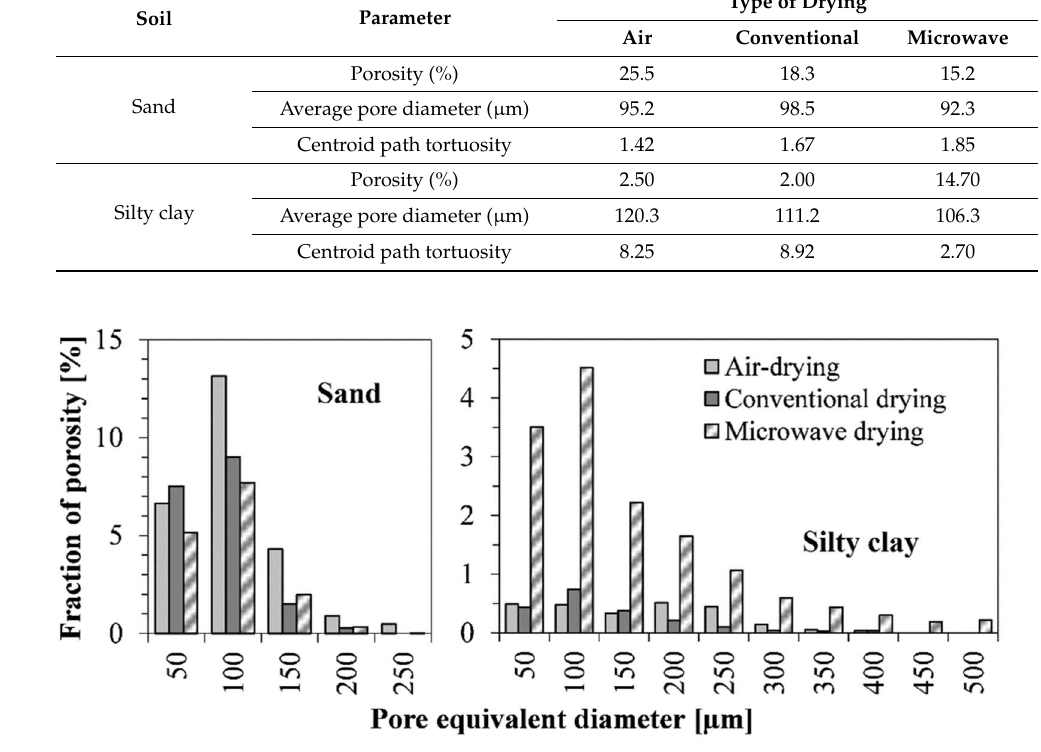
Figure 3. Pore volume fraction by equivalent diameter.